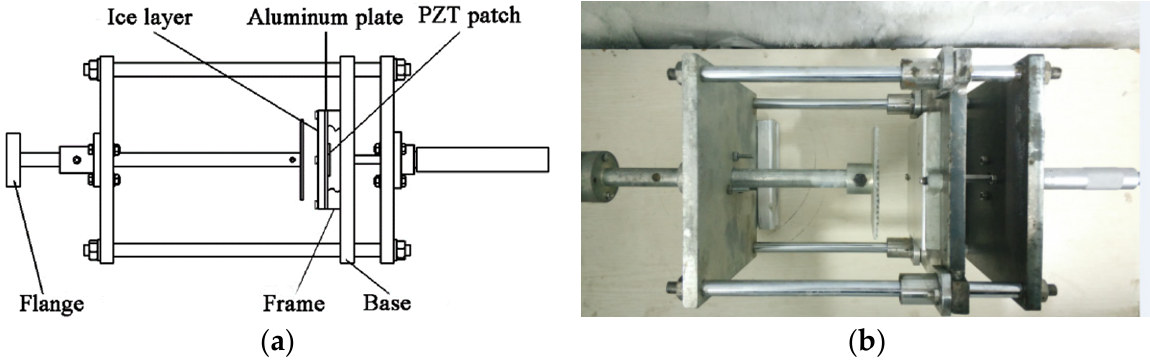
Figure 13. Measuring device for the adhesive torque of ice: ( a ) sketch map of the measuring device; ( b ) prototype of the measuring device.